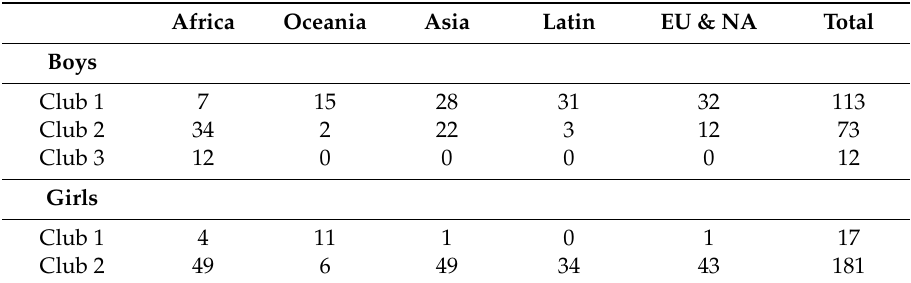
Table A2. Number of countries by Club and